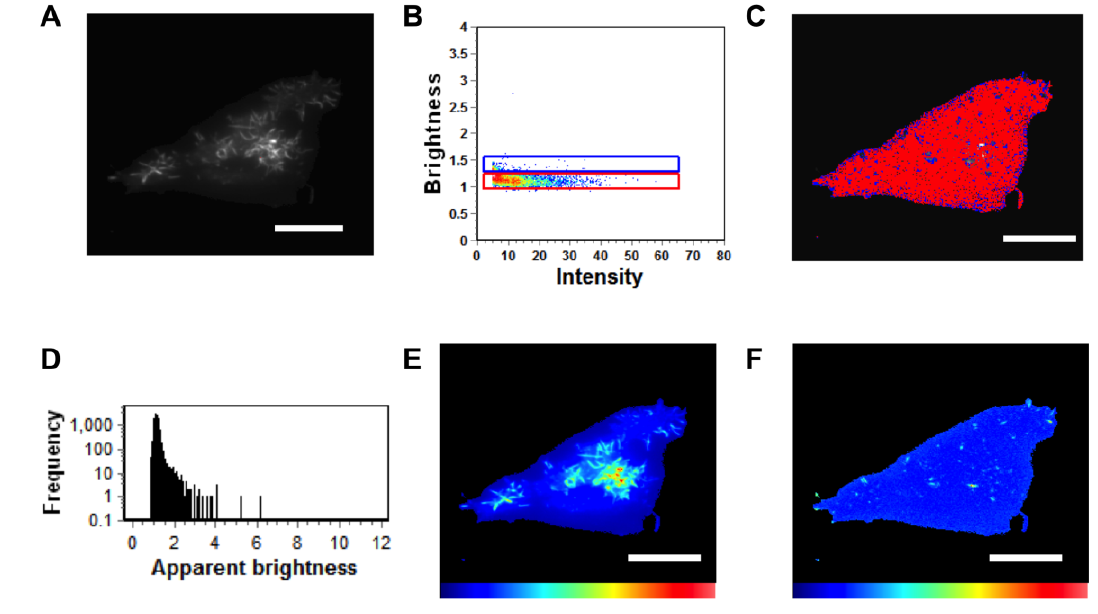
Figure 6. N&B Analysis of K127A. ( A ) TIRF microscopy was used to image EGFP-VP40-K127A expressed in HEK293 cells elucidating VP40 enriched PM protrusions. ( B ) Brightness versus intensity plot displaying monomers and dimers (red box) and trimers and tetramers (blue box). Note that little to no hexamers are detected in the brightness versus intensity plot. ( C ) Brightness distribution of K127A at or on the PM displaying monomers or dimers (red) and trimers and tetramers (blue). ( D ) Frequency versus apparent brightness plot demonstrates significantly lower oligomerization of K127A (See Figure 5G also) at or near the PM of HEK293 cells. ( E ) TIRF intensity image displaying EGFP-VP40-K127A distribution at or near the PM (blue = least intense; red = most intense). VP40 oligomers are enriched in the cellular protrusions. ( F ) The cellular brightness map of EGFP-VP40-K127A from the TIRF image demonstrates the significant reduction in oligomerization compared to WT (blue = least intense; red = most intense). Scale bar = 18